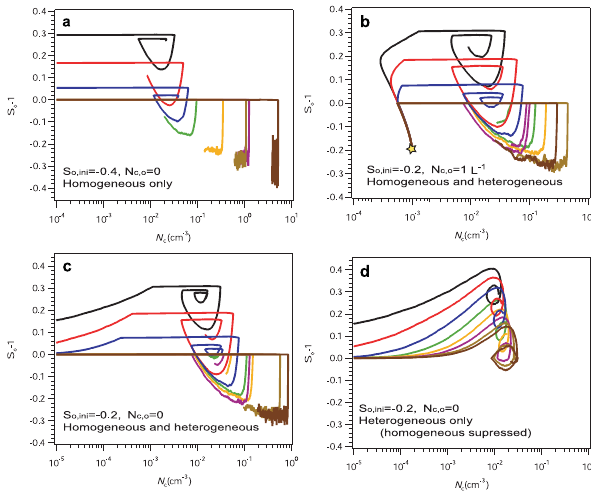
Fig. 8. Similar to Fig. 6, varying initial S and N c and the active freezing mechanism.